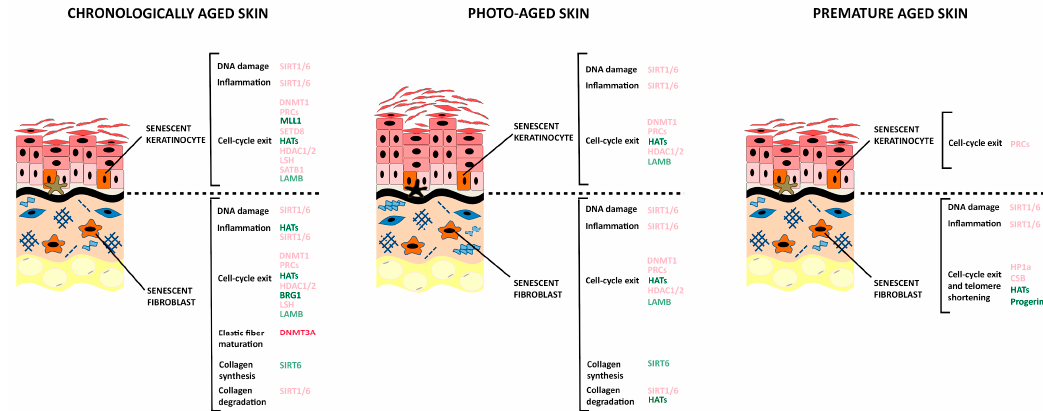
Figure 2. De-regulation of epigenetic modifiers affecting senescent epidermal keratinocytes and senescent dermal fibroblasts in chronologically-, photo- and premature-aged skin. Senescent cells are characterized by alterations of several cellular processes (DNA damage response, inflammation, and cell-cycle exit). Senescent fibroblasts display a modified metabolism of collagen and elastic fibers (elastic fiber maturation, collagen synthesis, and collagen degradation). Epigenetic modifiers inhibiting the cellular processes are indicated in light red when down-regulated and in dark red when up-regulated (or not down-regulated). Epigenetic modifiers activating the cellular processes are indicated in light green when down-regulated and in dark green when up-regulated (or not down-regulated).